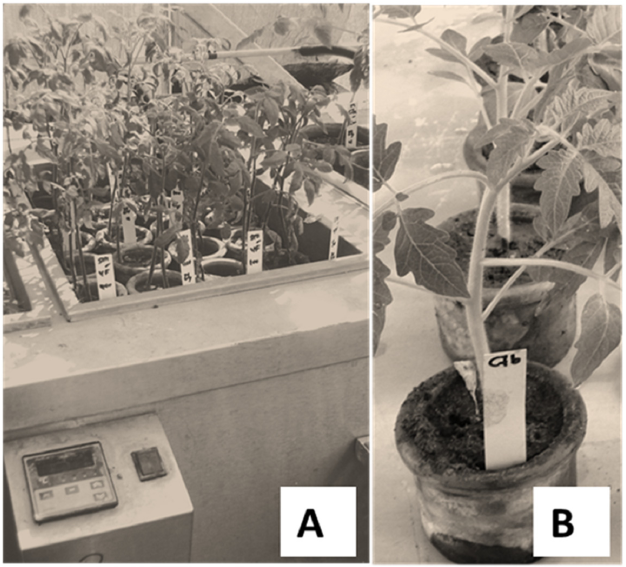
Figure 1. ( A ) Potted tomato plants growing in temperature-controlled benches; ( B ) single plants in 100 cm 3 clay pots. Plants were provided with a 12 h light/dark regime and regularly watered with Hoagland’s solution. Plants to be treated were grown to an average weight range of 3.0–5.0 g. The chemical structures of the antioxidant compounds used to treat the plants and test their effect on RKN infection are shown in Figure 2.